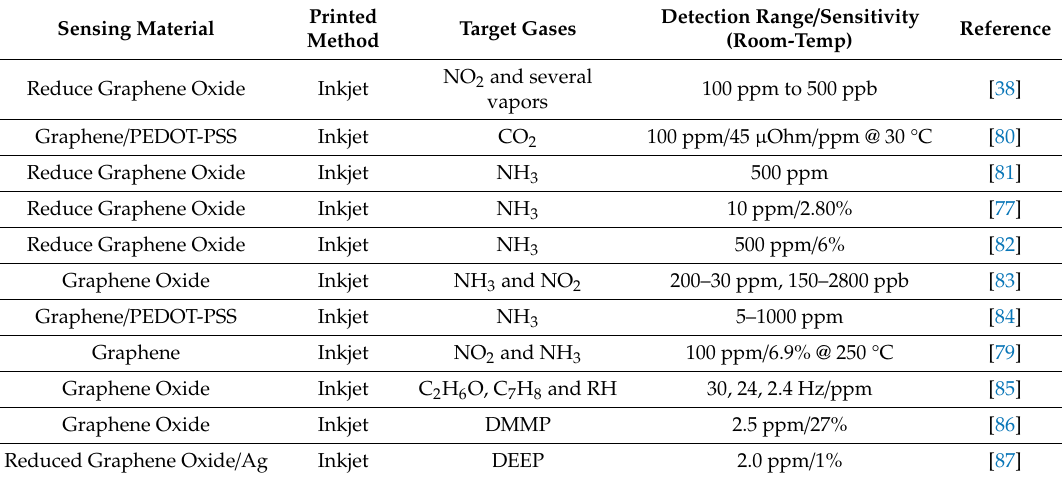
Table 1. Printed graphene gas